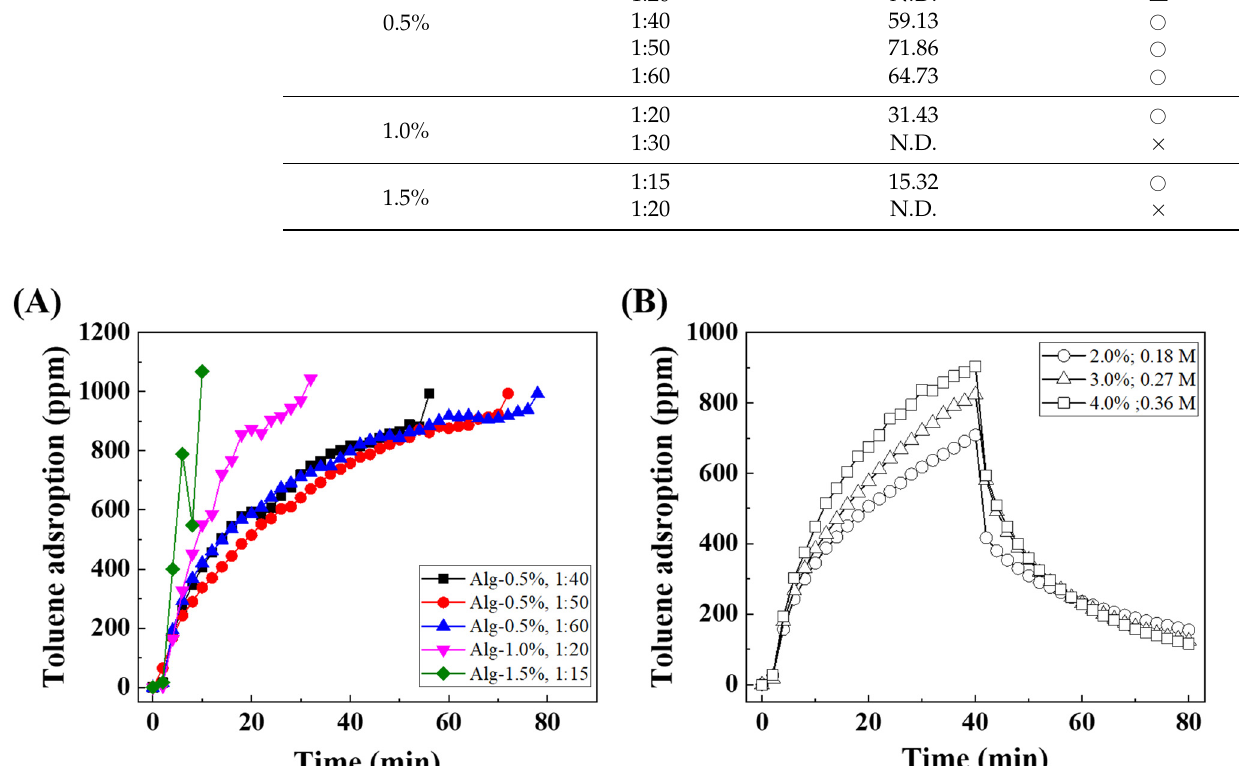
Figure 5. ( A ) Toluene adsorption curve depending on alginate concentration and weight ratio between alginate and PCH; ( B ) toluene adsorption–desorption curve of Alg-PCH depending on concentration of CaCl 2 solution (circle; 2%, triangle; 3% and square; 4%) with 40 min cycle.